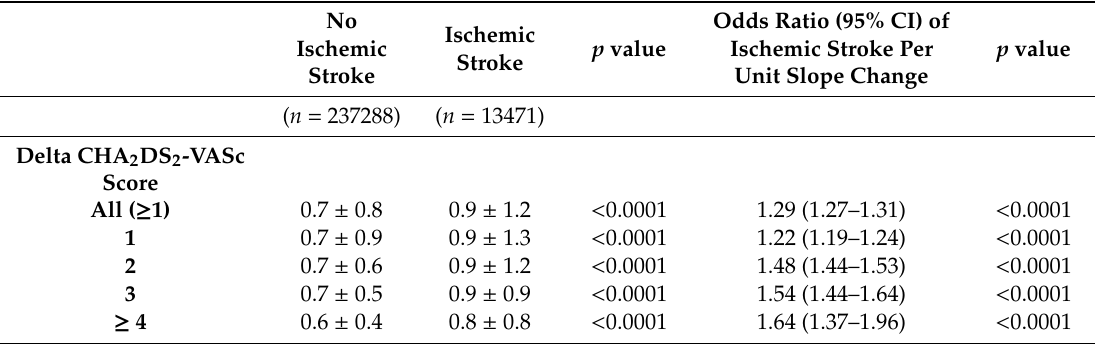
Table 4. Slope of the change of c CHA 2 DS 2 -VASc score and the risk of ischemic stroke in each group of delta CHA 2 DS 2 -VASc